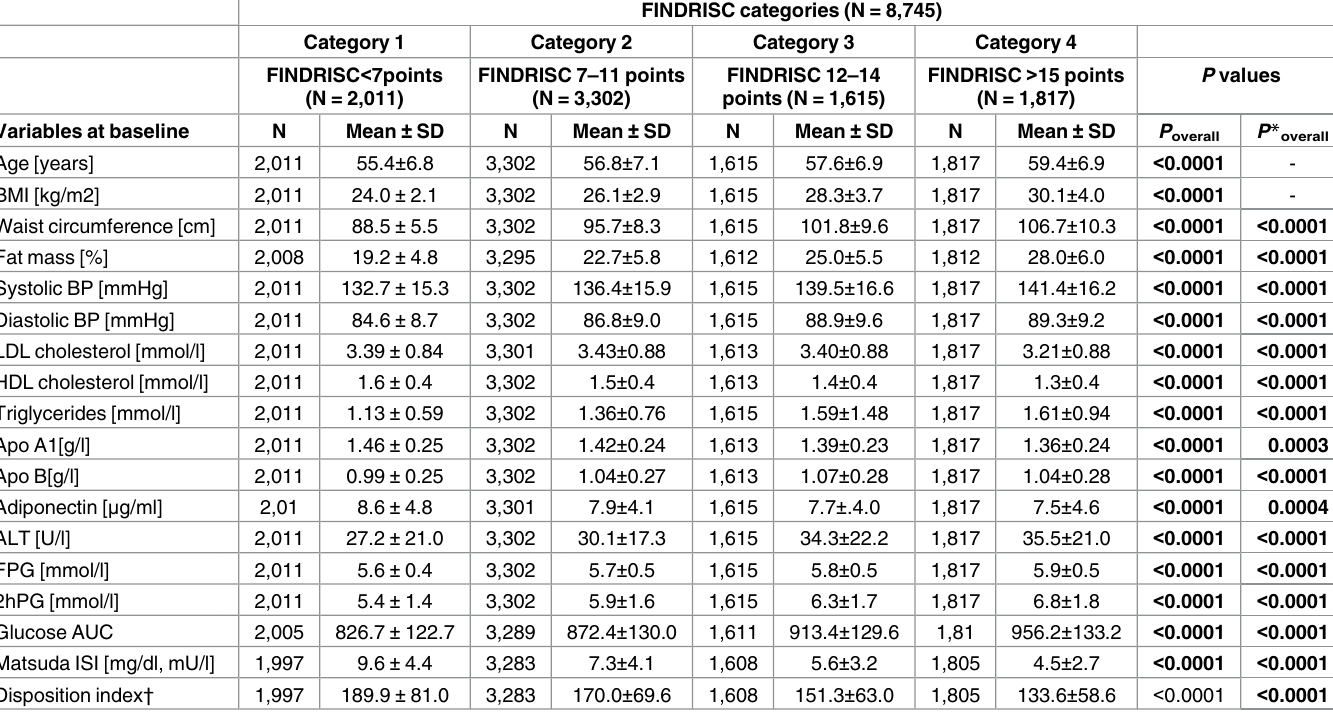
Table 1. Clinical and metabolic characteristics of participants at the METSIM baseline study in the categories of Finnish Diabetes Risk Score